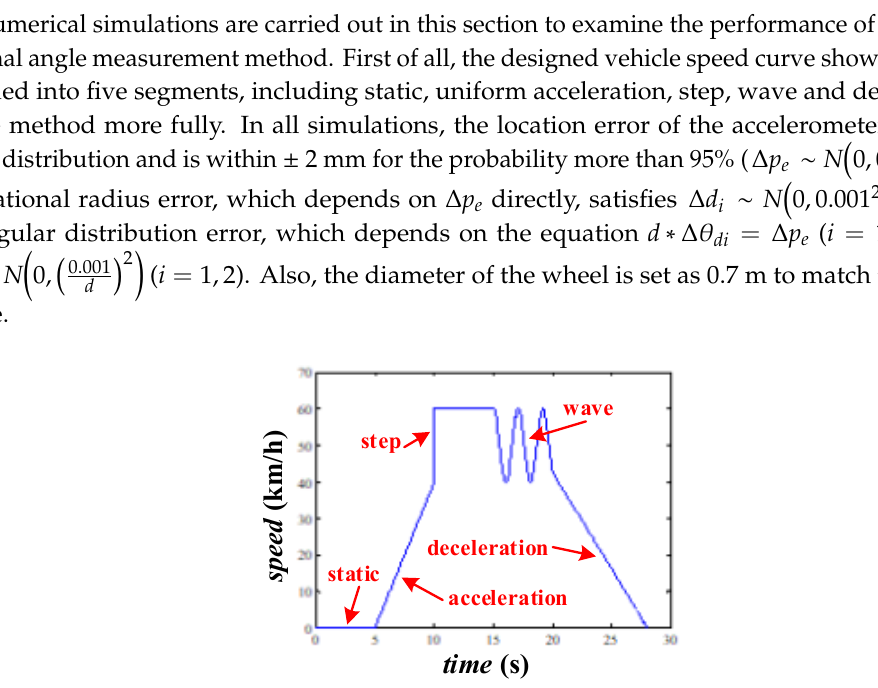
Figure 11. Vehicle speed curve.